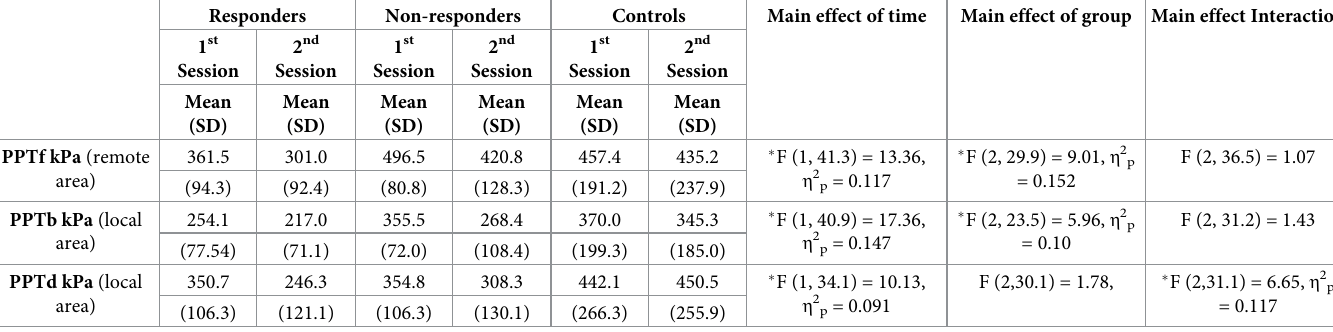
PPT, pressure pain threshold; PPTf, pressure pain threshold left flexor; PPTb, pressure pain threshold right biceps; PPTd, pressure pain threshold right deltoid. � denotes significant main effect p < 0.05.